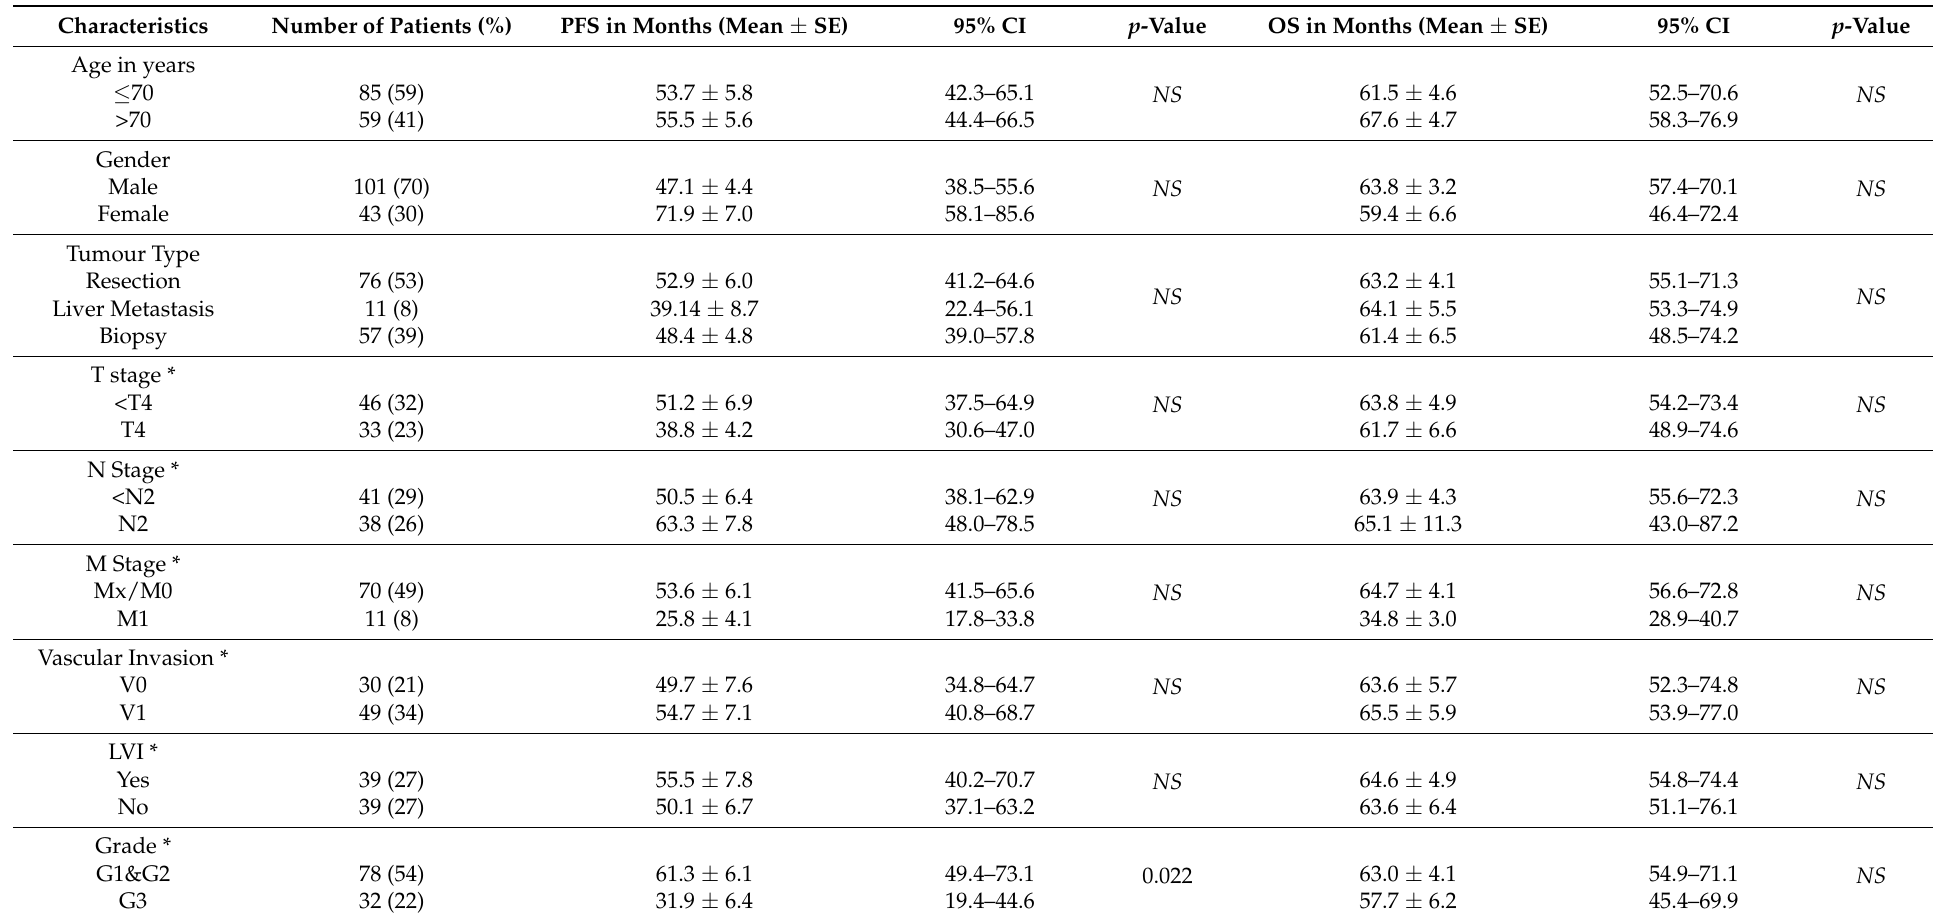
Table 1. Clinicopathological parameters and survival of 144 metastatic colorectal cancer (mCRC) patients treated with anti-epidermal growth factor receptor (EGFR) (mAb) cetuximab or panitumumab. Progression free survival (PFS) and overall survival (OS) relative to the indicated features were determined by Kaplan–Meier analysis and the log-rank test. p -Value of ≤ 0.05 was considered